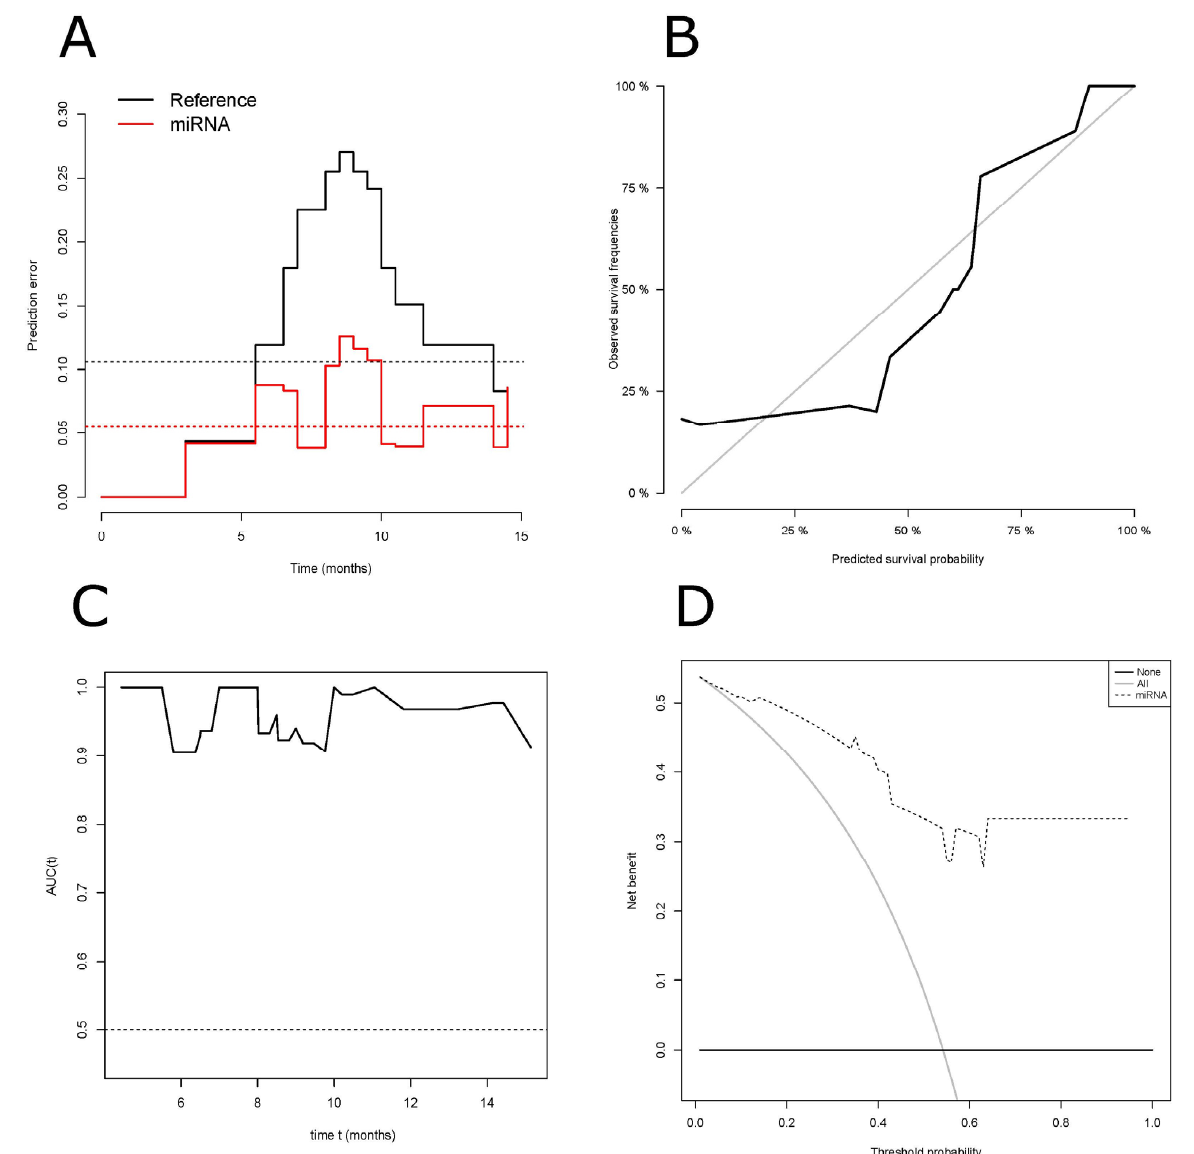
Figure 3. Assessment of the model’s performance. ( A ) Prediction error curves for Brier scores based on the miRNA signature stratification, and also on estimates for all patients without any stratification applied (reference scenario curve). For a single patient, the Brier score at the time t is defined as the squared difference between the observed survival status and the predicted outcome probability. Red dotted line = IBS for the ct-miRNA model; black dotted line = IBS for the reference scenario. ( B ) Calibration plot for PFS (progression-free survival) at the landmark follow-up time point of 8.5 months. The plot shows the predictions obtained by the model on the x -axis and the observed outcomes on the y -axis. ( C ) Area under the ROC curves (AUC) based on our ct-miRNA model’s fitting of the PFS, obtained from a time-dependent ROC analysis. ( D ) DCA (decision curve analysis) for the model’s efficacy at predicting progression in DIPG, and to assess the clinical utility of the proposed miRNA model. DCA shows, graphically, the clinical usefulness of the ct-miRNA model based on a continuum of potential thresholds for patients’ risk of progression ( x -axis) and the net benefit of using the ct-miRNA model to stratify patients ( y -axis). The horizontal black line indicates the all-true negative rate (corresponding to the risk assumption that no patients had disease progression at 8.5 months) and the diagonal gray line indicates the all-true positive rate (corresponding to the risk assumption that all patients had disease progression at 8.5 months). The dotted line indicates an improvement in the prediction achieved by the ct-miRNA